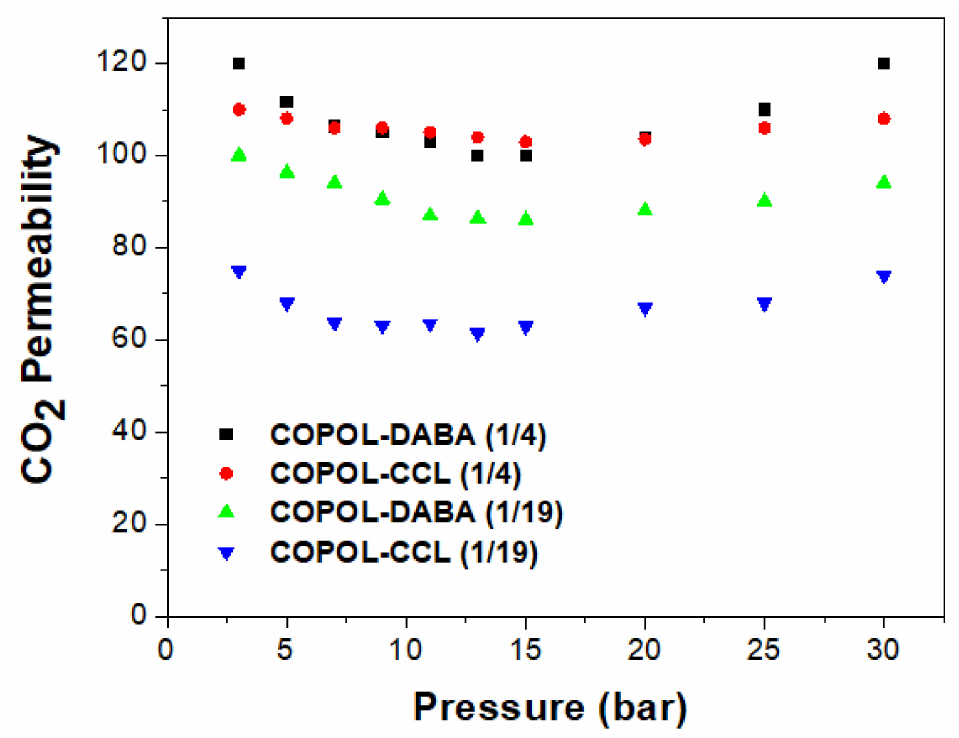
Figure 14. CO 2 permeability vs.